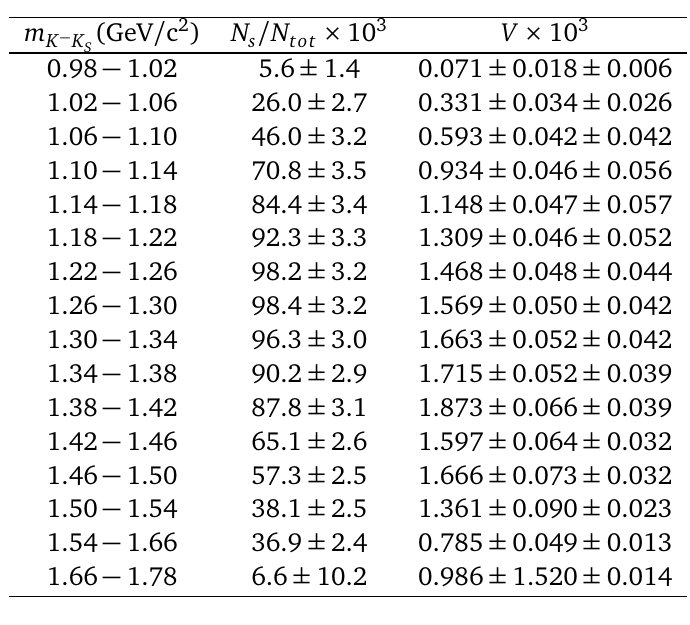
Table 1: Measured spectral function (V) of the τ − → K − K The columns report: the range of the bins, the normalized number of events, the value of the spectral function. The first error is statistical, the second